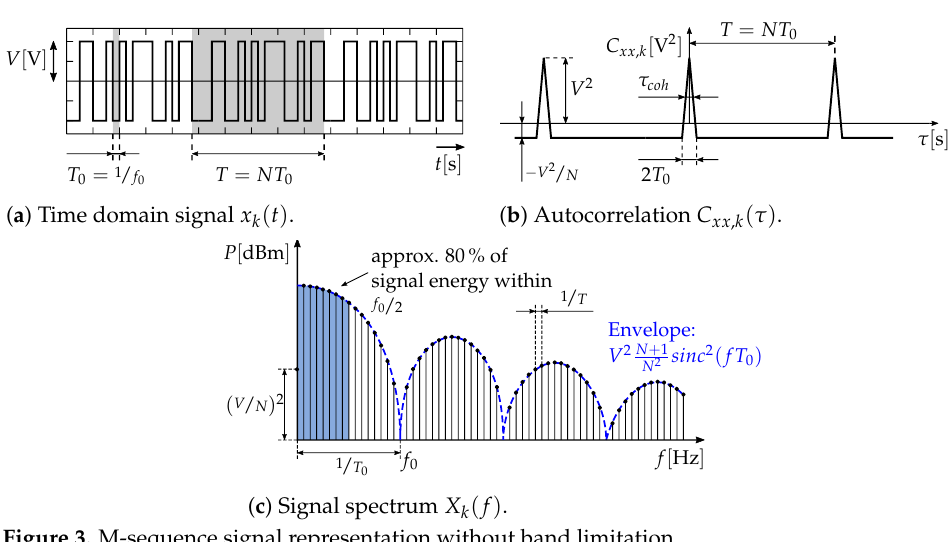
Figure 3. M-sequence signal representation without band